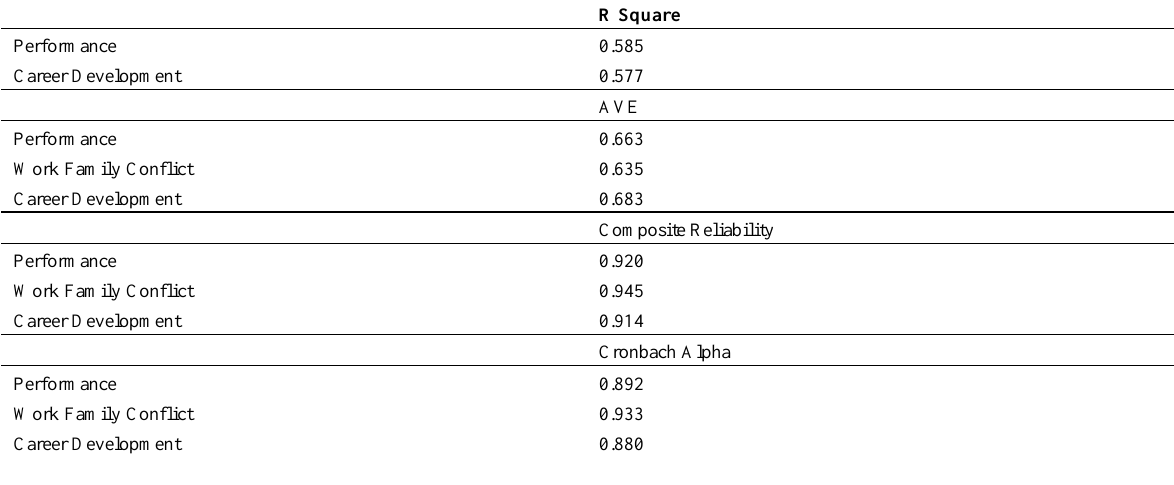
Table 2: Validity and Reliability Testing of The Model